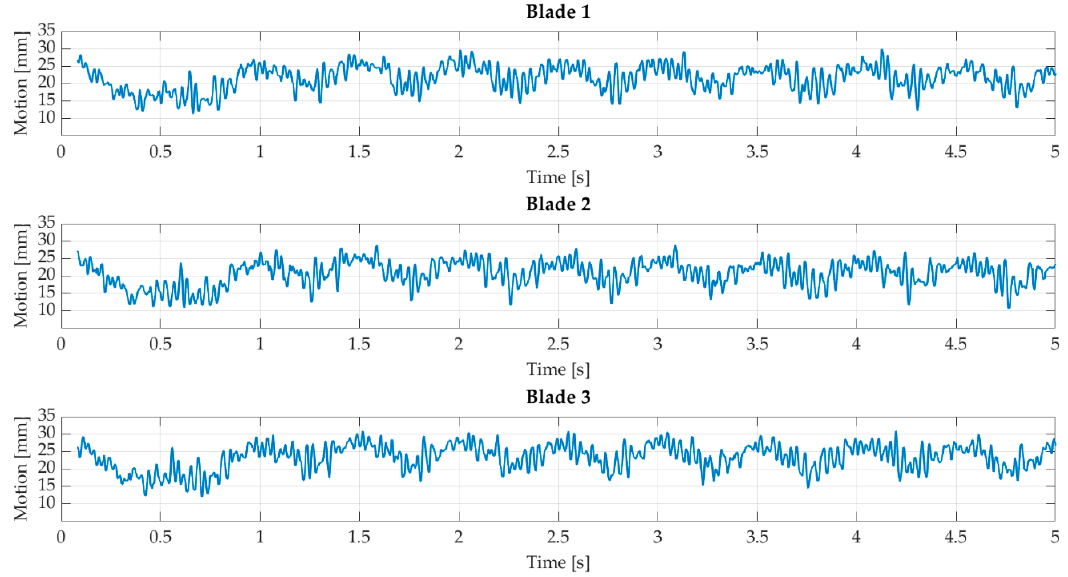
Figure 13. Blade deflection with sinusoidal inflow.